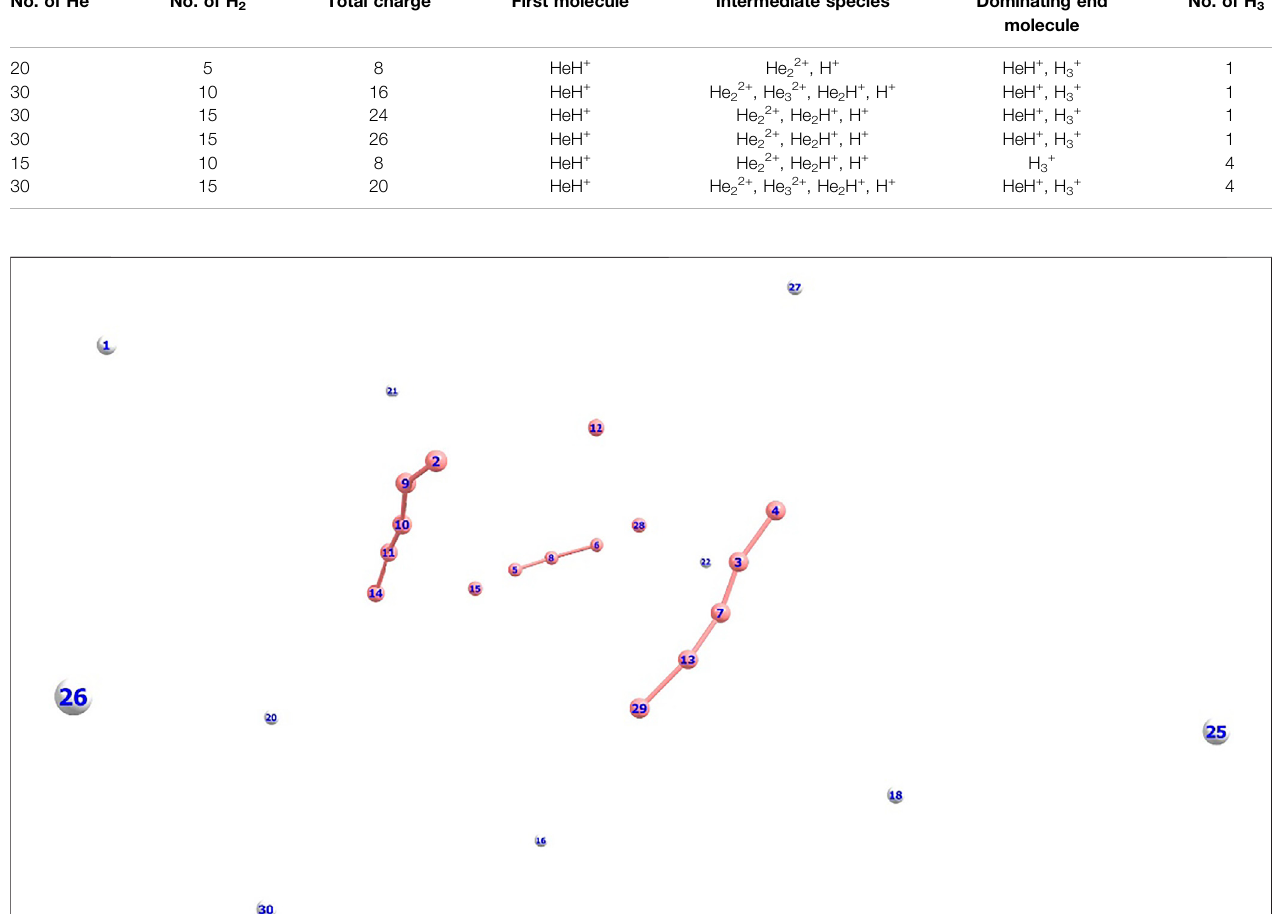
FIGURE 3 | Dicationic He chain formation during an AINR simulation of 15 H and 15 He atoms, with an overall positive charge of 20 (Color: He - peach, H - white).